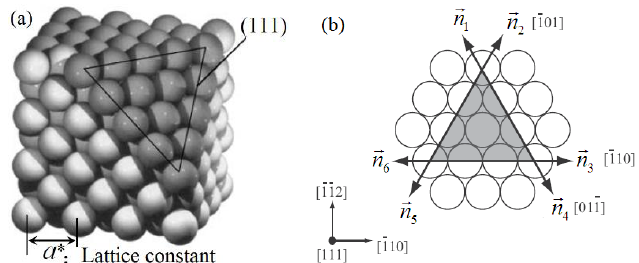
Figure 3. Three-dimensional (3D) atomic lattice of face-centered cubic (FCC) structure ( a ), the index of direction of atomic lattice arrangement in (111) plane of FCC structure [62] in two dimensions ( b ).